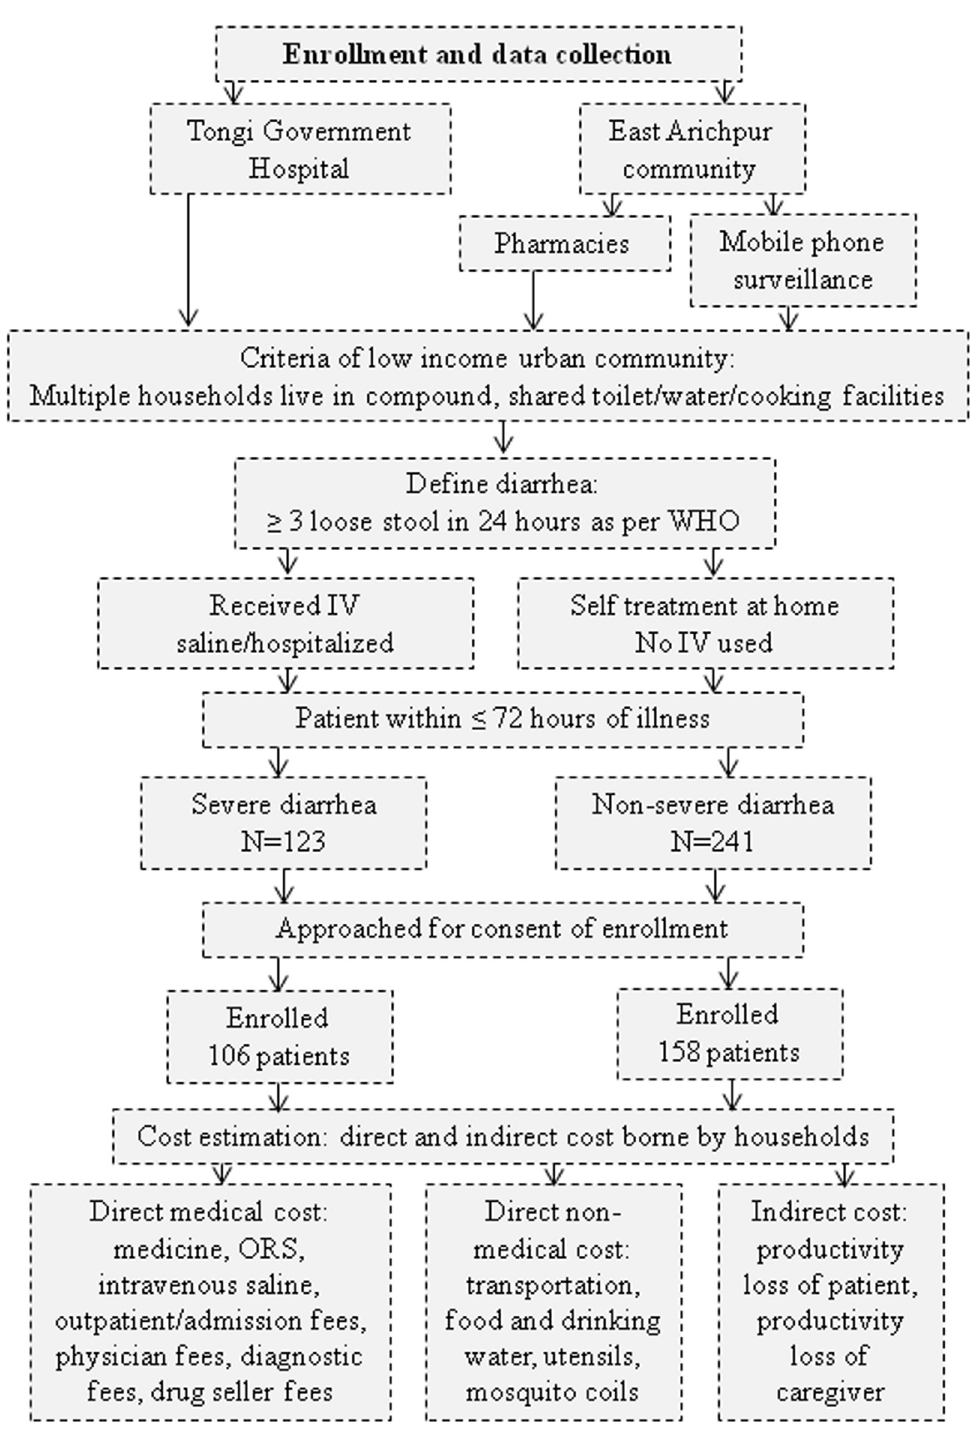
Fig 1. Participant enrollment process and cost data collection of the study conducted in Tongi Township in Dhaka, Bangladesh from September 2015 to June 2016.